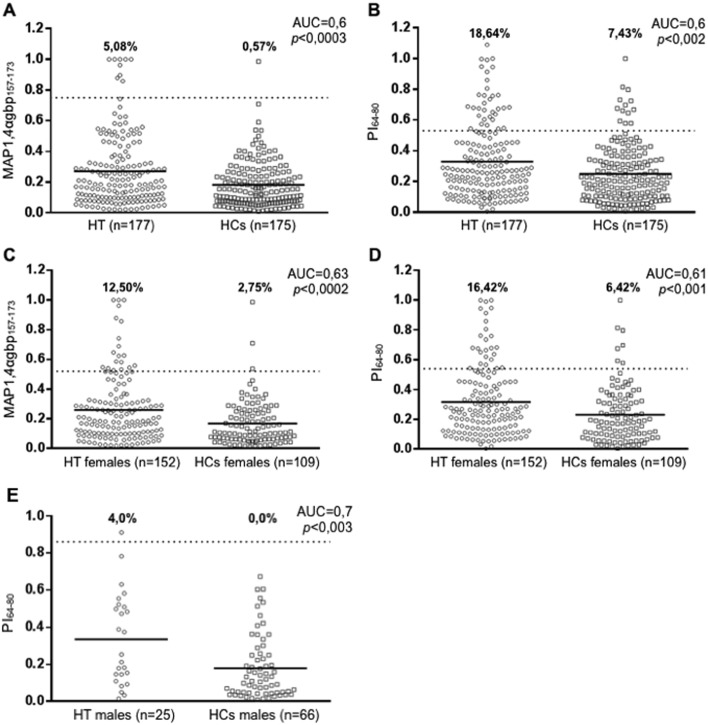
Sex-related prevalence of Abs against MAP1,4αgbp157-173/PI64-80 and PI46-61 in Sardinian HT patients and HCs.Plasma was tested for immunoreactivity against plate-coated homologous peptides MAP1,4αgbp157-173/PI64-80 and MAP2404c70-85/PI46-61. Statistical analyses were performed for all peptides separately in the context of entire study population (A, B), female (C, D) and male (E) HT subjects and HCs. The dotted lines indicate thresholds of positivity relative to each assay calculated by ROC analysis. The percentage of Abs-positive patients is reported on top of each distribution; horizontal bars correspond to means. AUC and p values (CI 95%) are indicated in the top right corner. Only statistically significant data are reported.